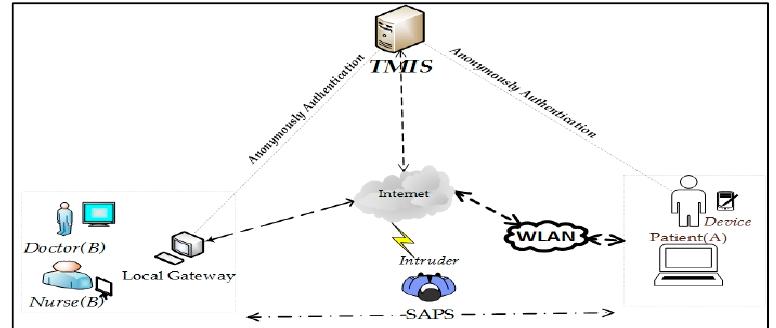
Figure 2. TMIS System Model.